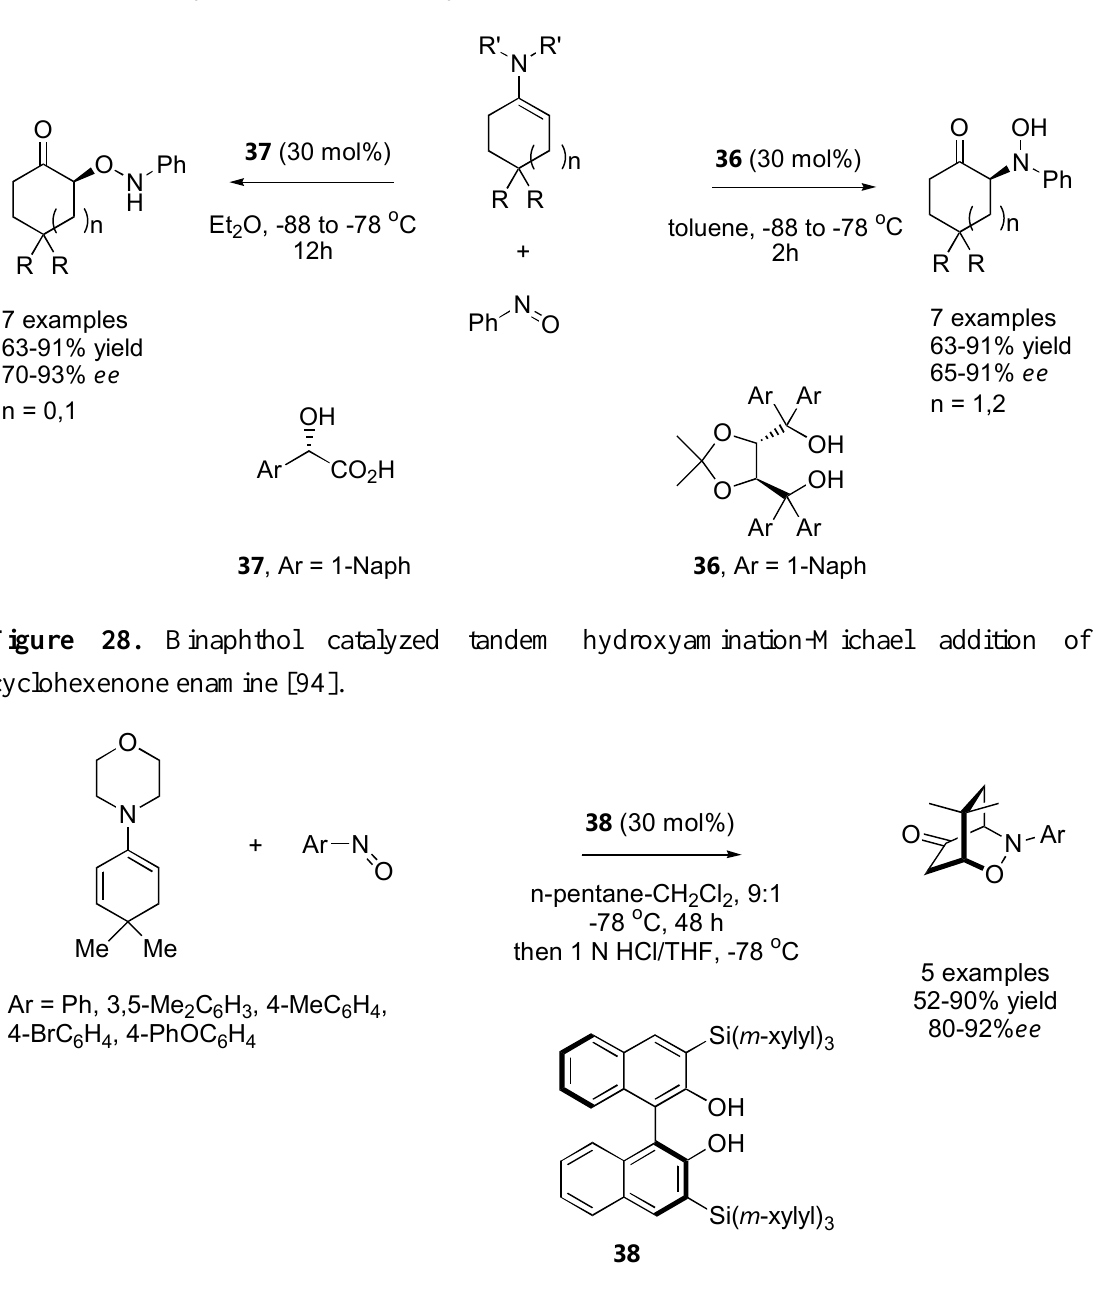
Figure 27. Regioselectivity control in reaction between a preformed enamine and nitrosobenzene by Brønsted acid catalysts [118].